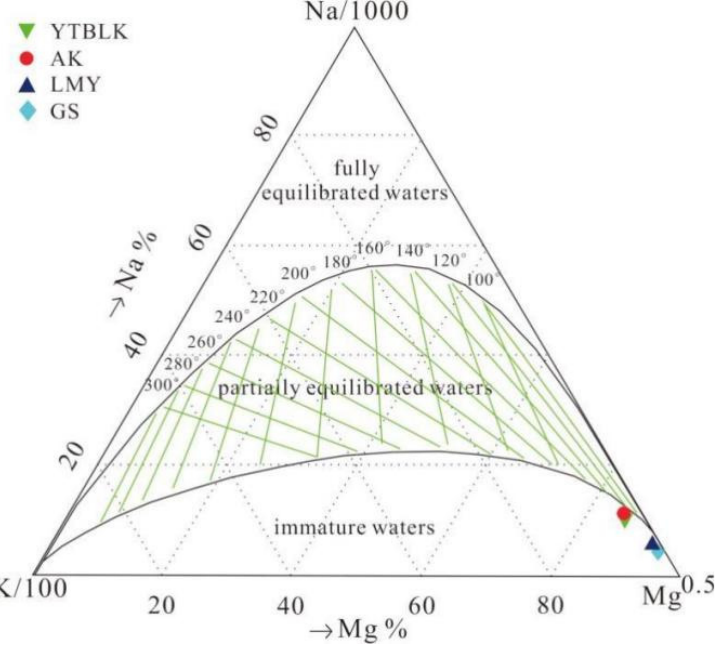
Figure 4. Distribution of aqueous samples shown on a Na/1000 ‐ K/100 ‐ Mg1/2 ternary diagram [45].